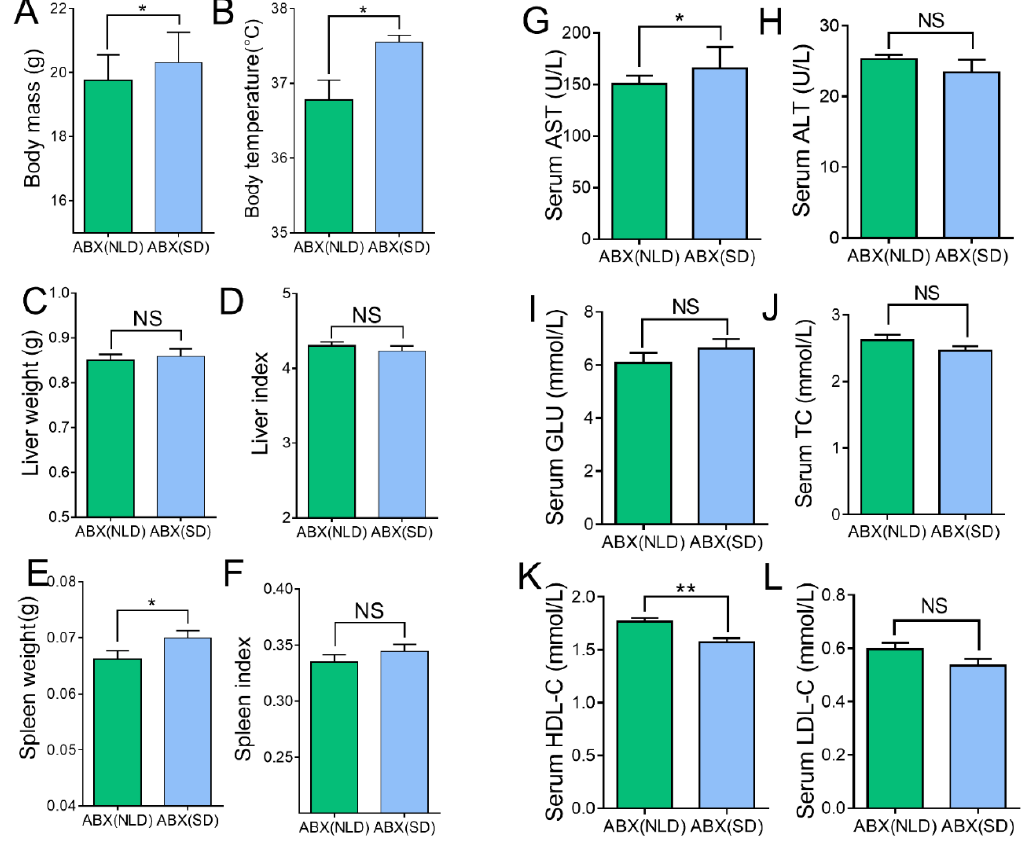
Figure 2. Body mass, body temperature, organ indexes, and serum biochemical indicators in ABX mice under NLD and SD. ABX (NLD), the antibiotic-treated mice managed under normal light–dark cycle; ABX (SD), the antibiotic-treated mice managed under short-day cycle. Representative charts of body weight ( A ), body temperature ( B ), liver weight ( C ), liver index ( D ), spleen weight ( E ), spleen index ( F ), and concentrations of serum AST ( G ), ALT ( H ), GLU ( I ), TC ( J ), HDL-C ( K ), and LDL-C ( L ) were determined in ABX mice under NLD and SD. Values were means, with standard error of the mean. * p < 0.05, ** p < 0.01, NS p > 0.05.